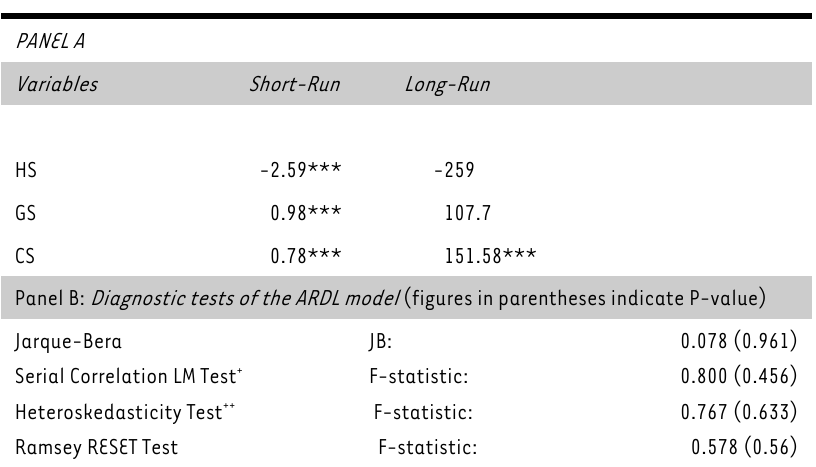
Short-run and long-run relationships